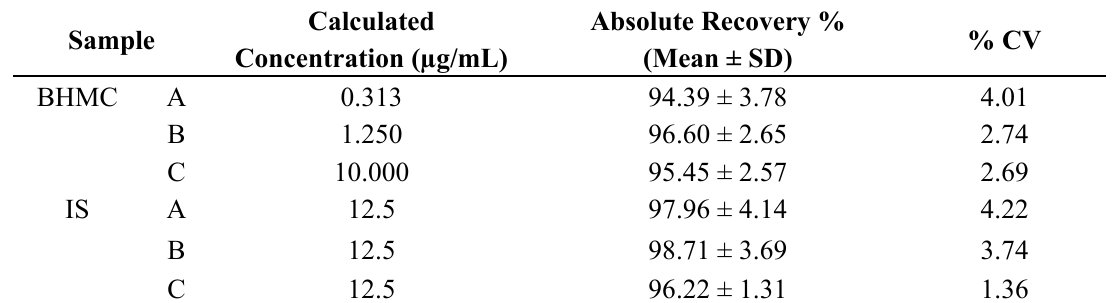
Table 1. Extraction efficiency (n = 6) of various concentrations of BHMC and IS.